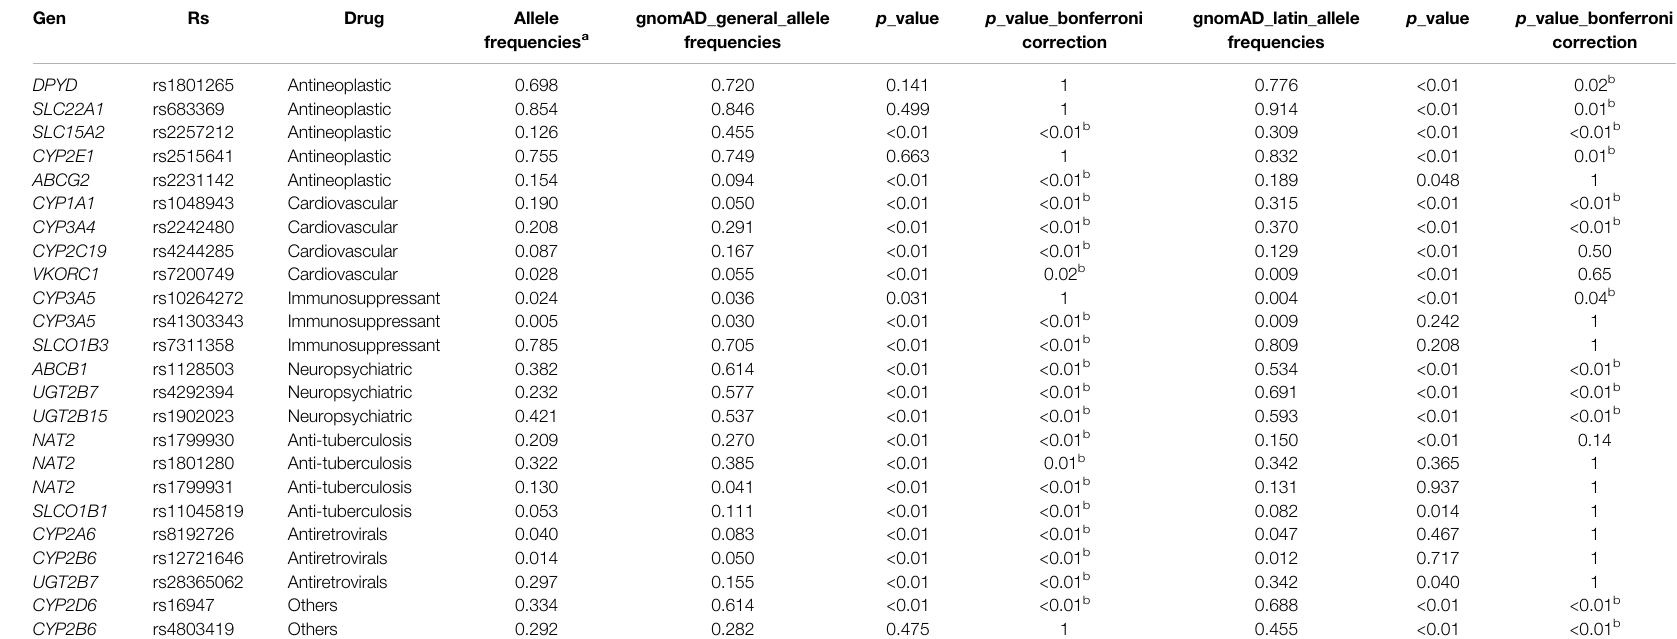
TABLE 4 | Functionally relevant SNPs allelic frequencies